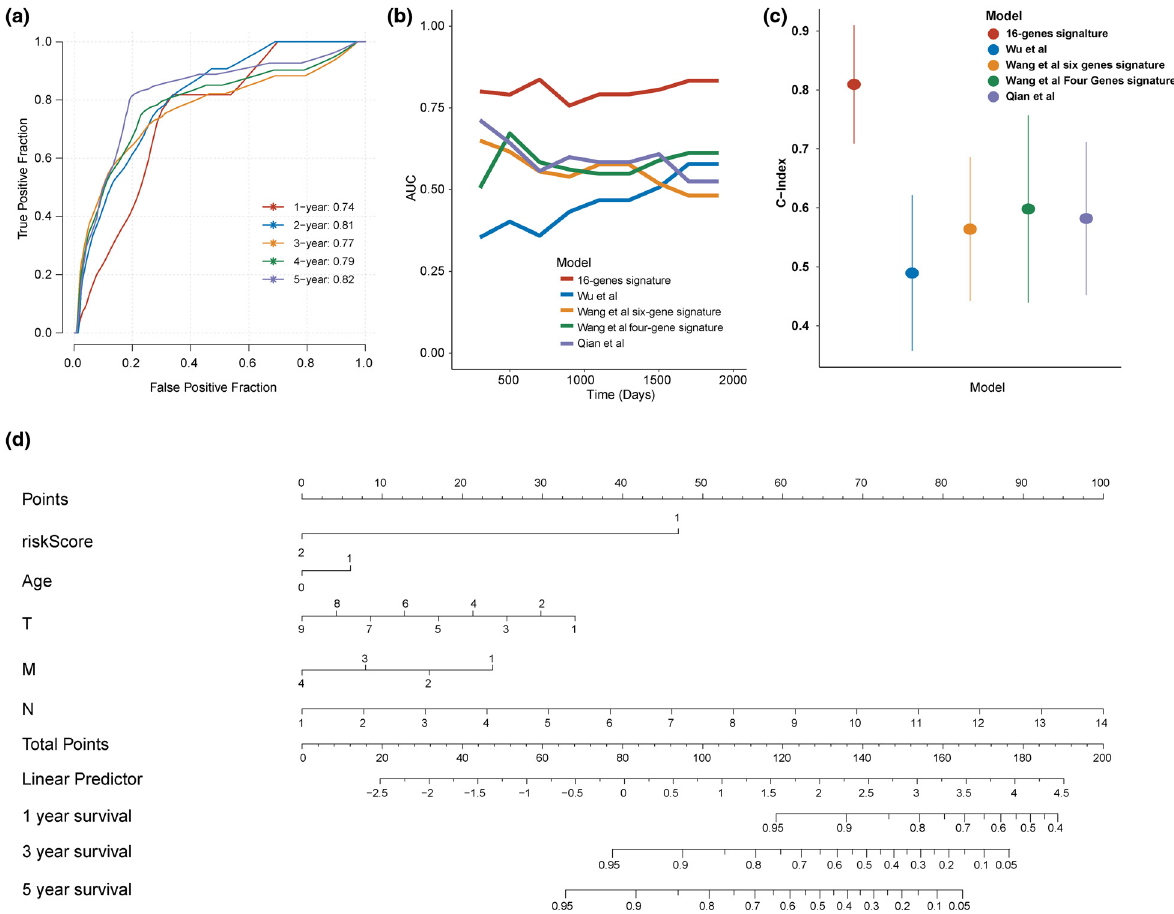
Figure 4: Evaluation of predictive e ffi ciency of the 16 - gene model in the TCGA – TNBC cohort. ( a ) Time - dependent ROC curve of 1, 2, 3, 4, and 5 years. ( b ) Comparison of the value of AUC between the 16 - gene model and other four published models. ( c ) Comparison of the value of C - index between the 16 - gene model and other four published models. ( d ) A nomogram based on the 16 - gene model in